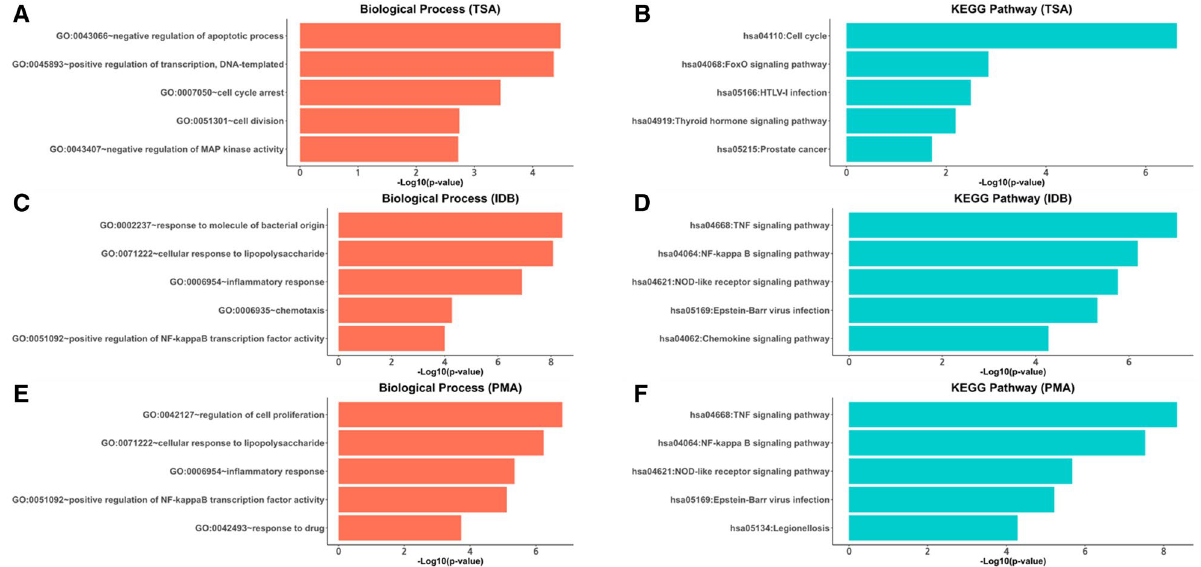
Figure 3. Results of Gene Ontology (GO) term and Kyoto Encyclopedia of Genes and Genomes (KEGG) enrichment analysis for each TSA, IDB, and PMA-specific gene. Due to a large number of significant results, we visualized the top five significant terms based on statistical significance (p < 0.05) for each category. ( A , B ) Enriched GO terms of biological processes and KEGG pathways for TSA-specific genes, respectively. ( C , D ) Enriched GO terms of biological processes and KEGG pathways for IDB-specific genes, respectively. ( E , F ) Enriched GO terms of biological processes and KEGG pathways for PMA-specific genes, respectively. TSA Trichostatin-A, IDB Ingenol 3,20-dibenzoate, PMA